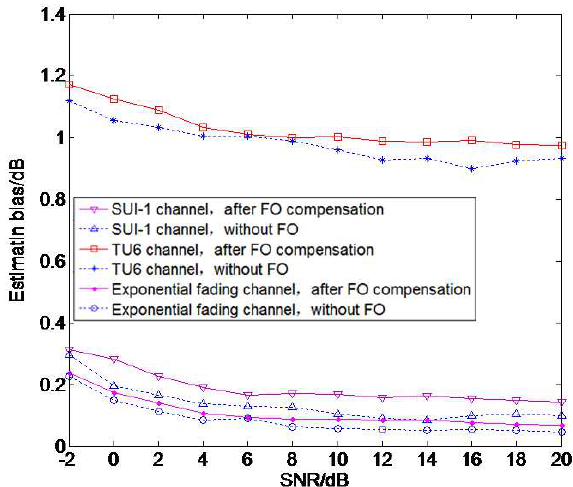
Figure 7. Comparison of compensating frequency offset with no frequency